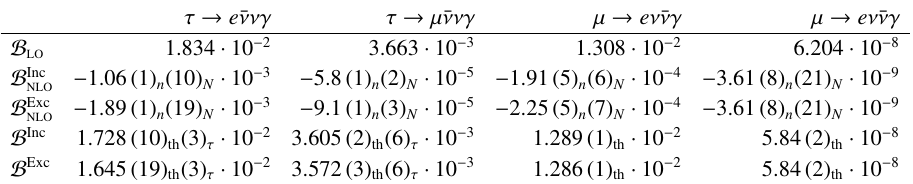
Table 1. Branching ratios of radiative µ and τ leptonic decays. The minimum photon energy ω 0 is 10 MeV, except for the last column, where ω 0 = 40 MeV and E min exclusive ( B Inc / Exc ) predictions are separated into LO contributions ( B ( B Inc / Exc ). Uncertainties were estimated for uncomputed NNLO corrections ( N ), numerical ( n ) and the NLO experimental errors of the lifetimes ( τ ). The first two were combined into a total uncertainty